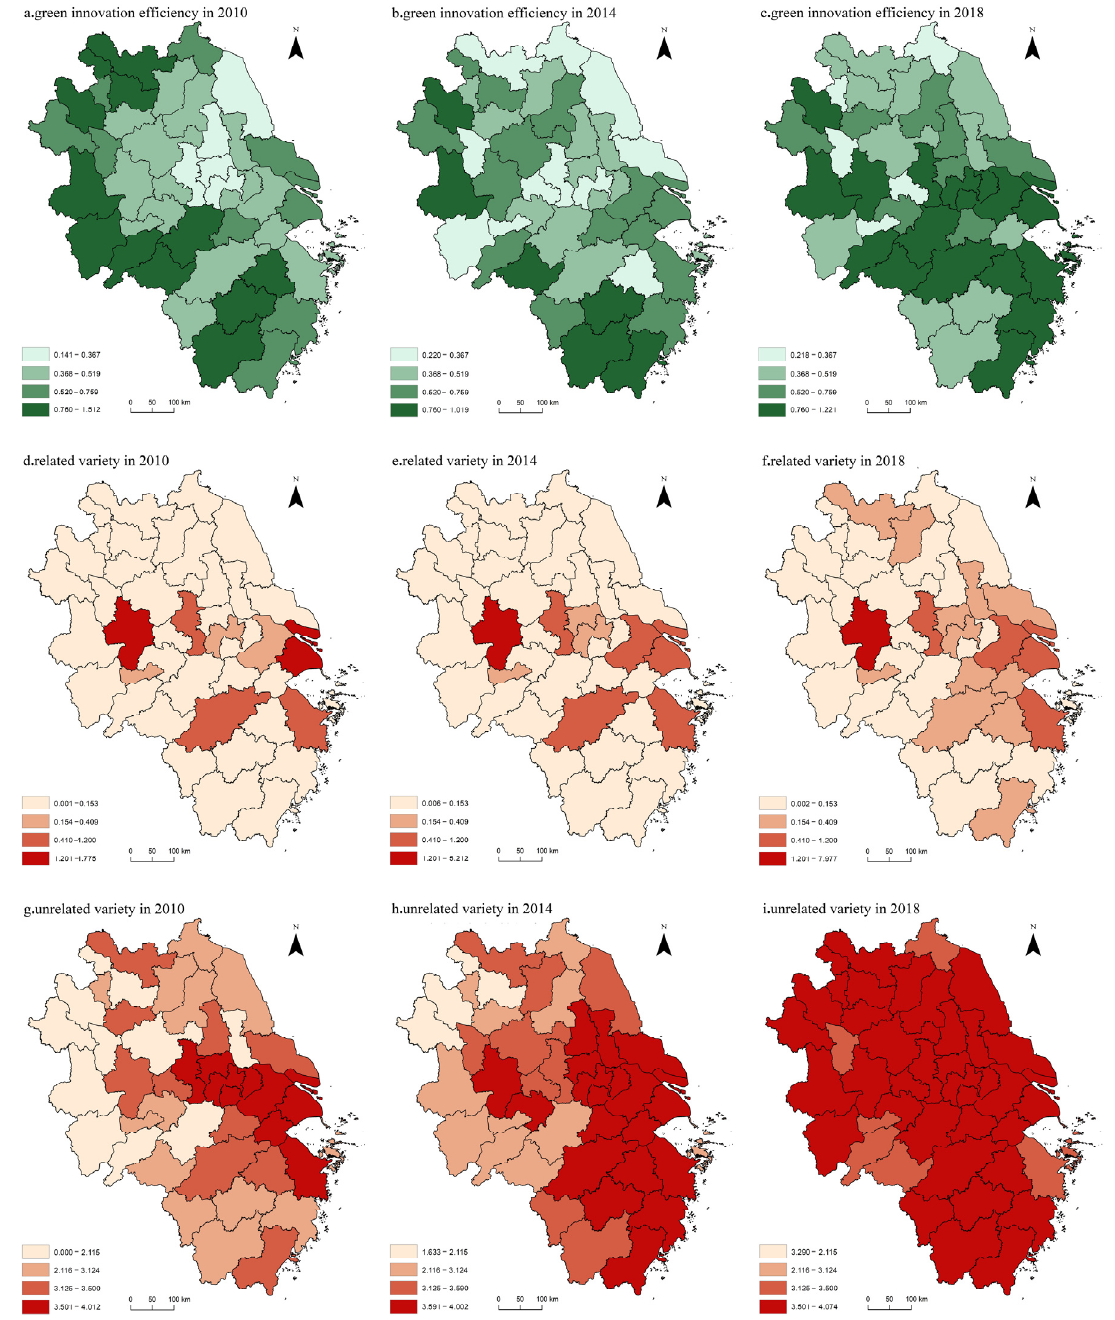
Figure 3. Spatial distribution of green innovation efficiency and related variety and unrelated variety in the Yangtze River Delta from 2010 to